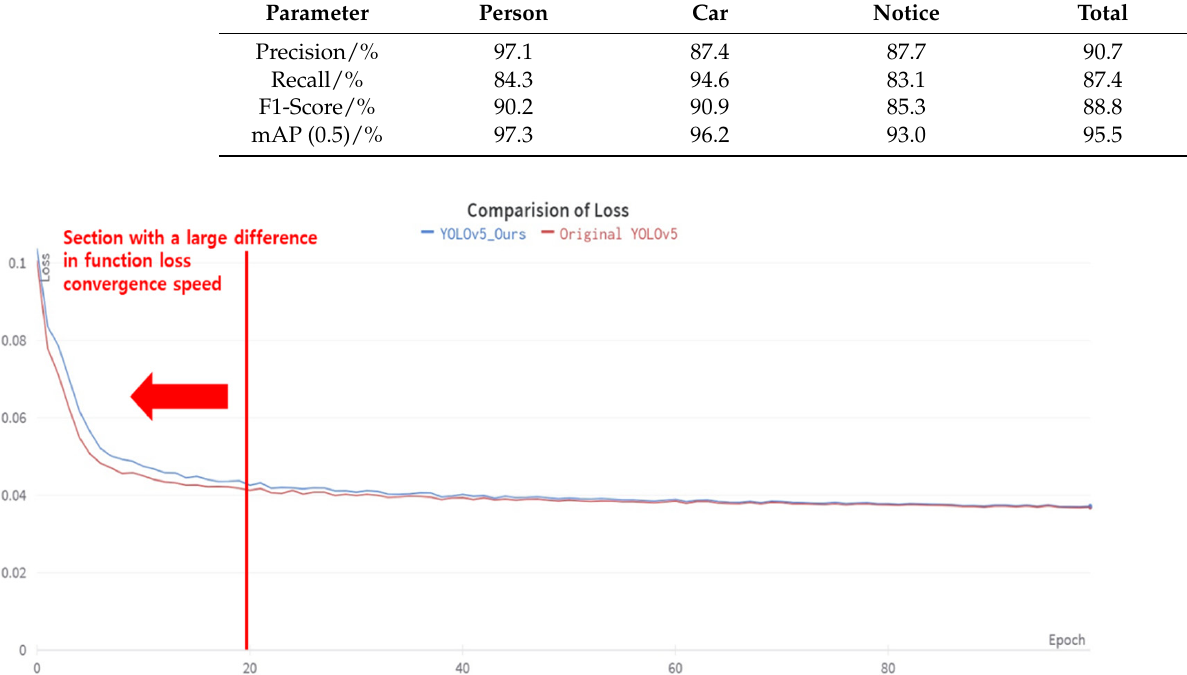
Figure 14. Comparison graph of function loss for Original YOLOv5 and YOLOv5_Ours model.